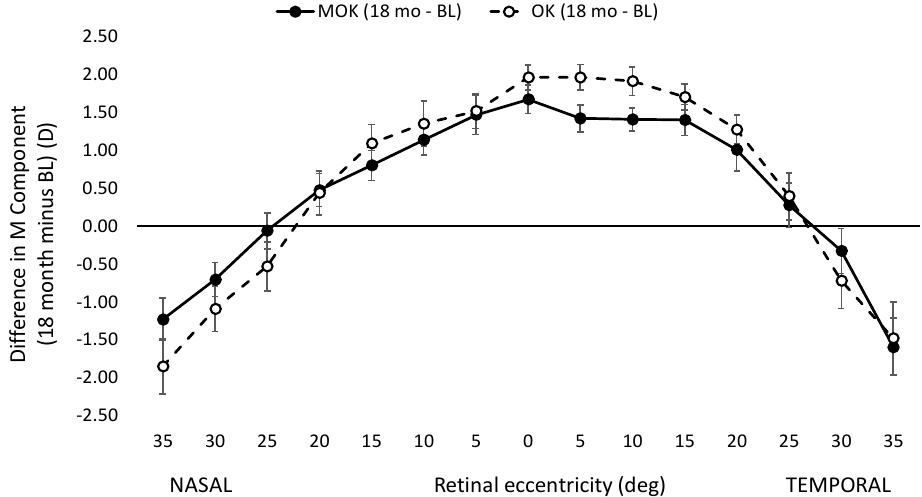
Figure A4. Changes in peripheral refractions between baseline (before lens wear) and after 18 months of lens wear for MOK-treated eyes (solid symbols and line) and OK-treated eyes (open symbols and dashed line). Error bars: ± 1 S.E.M.